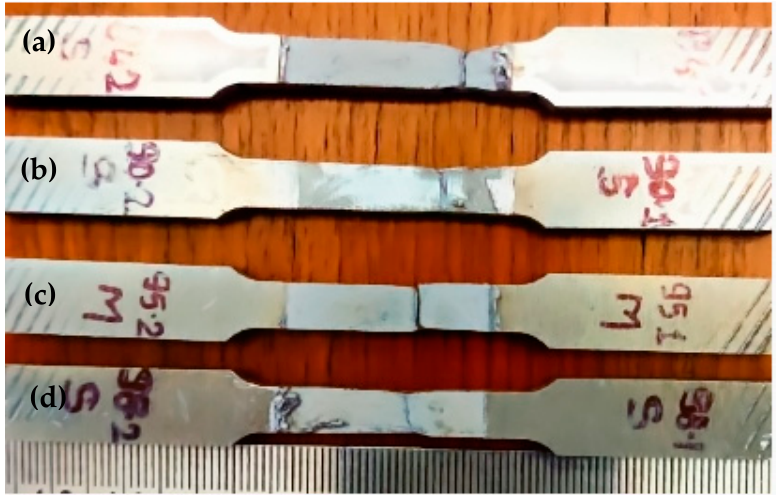
Figure 10. Fracture locations of the joints welded in different cooling conditions ( a ) NAC. ( b ) S-RM ( c ) S-IM ( d ) C-RJ.